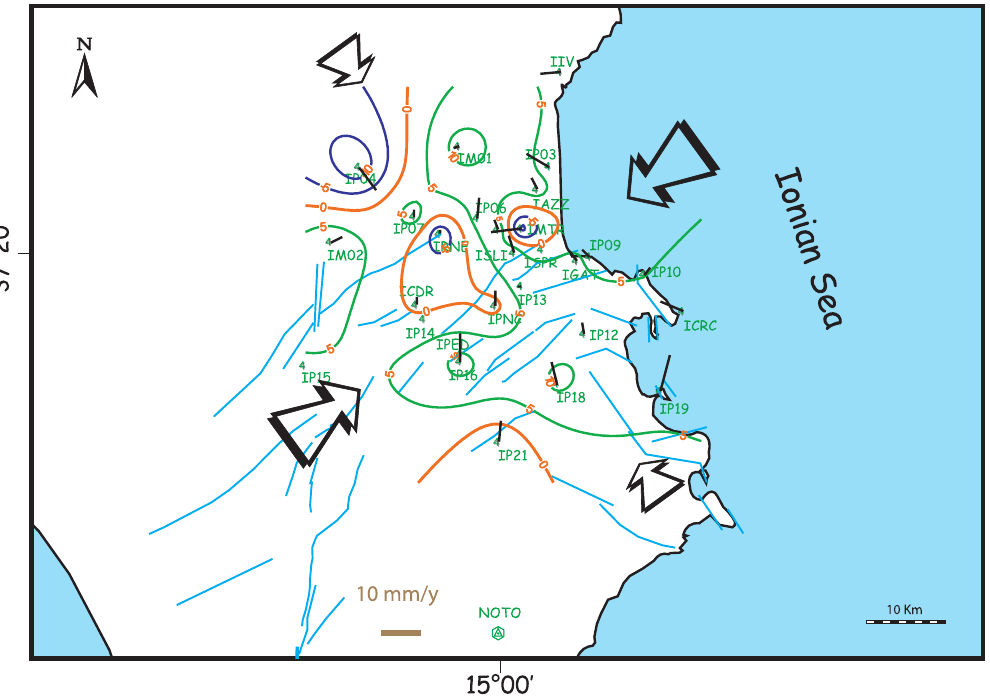
Fig. 4. Horizontal (vectors) and vertical (contours) velocities at the GPS stations (mm/yr) between 1998 and 2000 computed by fixing the IGS stations co-ordinates at epoch 2000.4. The contour interval is 5 mm/yr. Large arrows indicate the maximum and minimum shortening strain